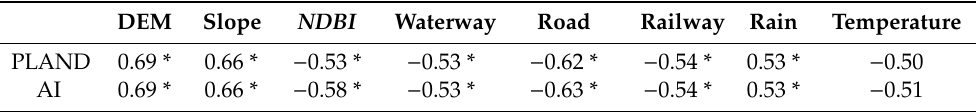
Table 3. Correlation coe ffi cients between the candidate variables and the urban greenness landscape indices, percentage of landscape (PLAND) and aggregation index (AI).